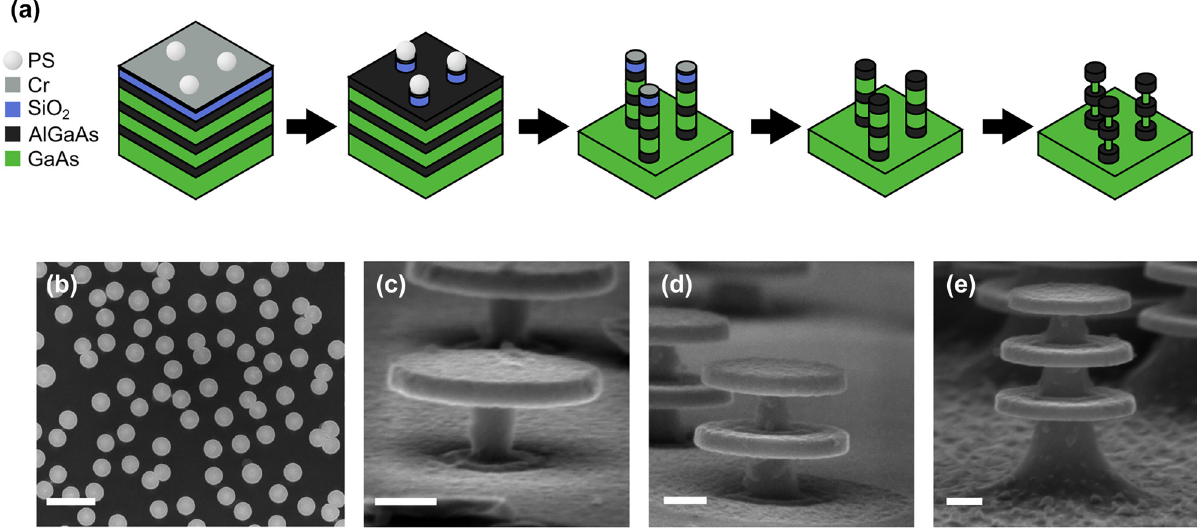
Figure 4: Fabrication steps to achieve stacked resonators. Start with AlGaAs/GaAs alternating multilayer sample, where the AlGaAs layers , and charged polystyrene (PS) spheres, (a) the are 50 nm thick and the GaAs spacing layers are 100 nm thick. After deposition of Cr, SiO 2 through dry etching. The subsequent AlGaAs/GaAs dry etch removes the spheres and is sphere pattern is transferred to the Cr and SiO 2 timed to etch through either one, two or three of the AlGaAs layers. Both masks are removed in HF and the GaAs is wet etched, in a O :citric acid mix. (b) A top view image of the final pillar structures, scale bar 1 μ m. (c)–(e) Tilted views of the finalized one, two and three H 2 2 AlGaAs nanodisk stacks. The scale bars are 100